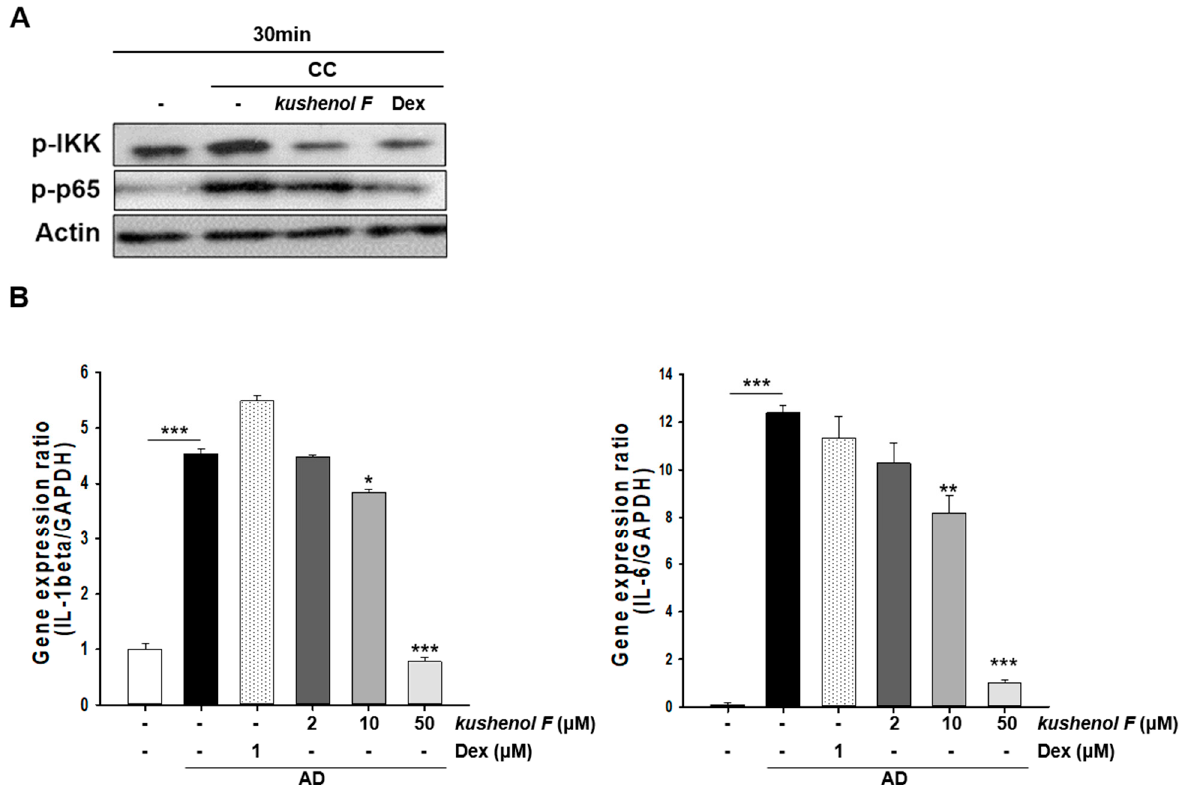
Figure 6. Effect of kushenol F on the inflammatory response in CC-induced NHEKs. ( A ) Effect of kushenol F on the NF- κ B signaling pathways. The cells were pretreated with kushenol F (10 µ M) or dexamethasone (10 μ M) for 1 h and were subsequently stimulated with CC for 30 min. The cells were subjected to Western blotting. β -actin was used as a loading control. ( B ) mRNA expression levels of IL-1 β and IL-6. Data are presented as the mean ± SD of three independent experiments. * p < 0.05, ** p < 0.01 and *** p < 0.001 vs. control. CC, cytokine combination; NHEK, normal human epithelial cell.